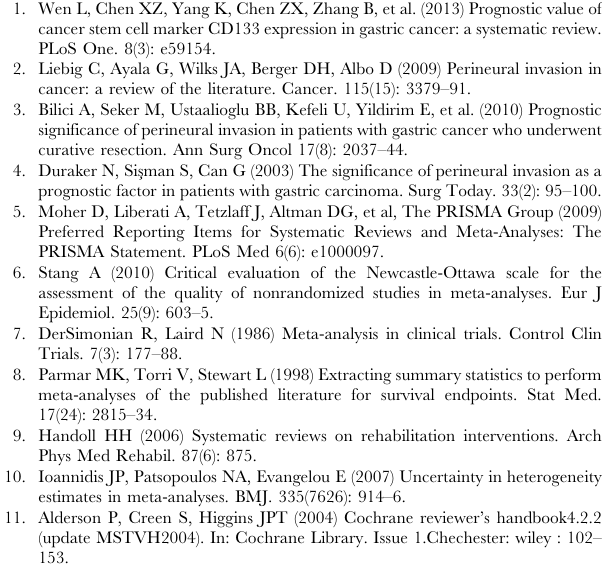
Table S1 Characteristics of the studies. Table S2 Statistical analysis data for OS of the studies.